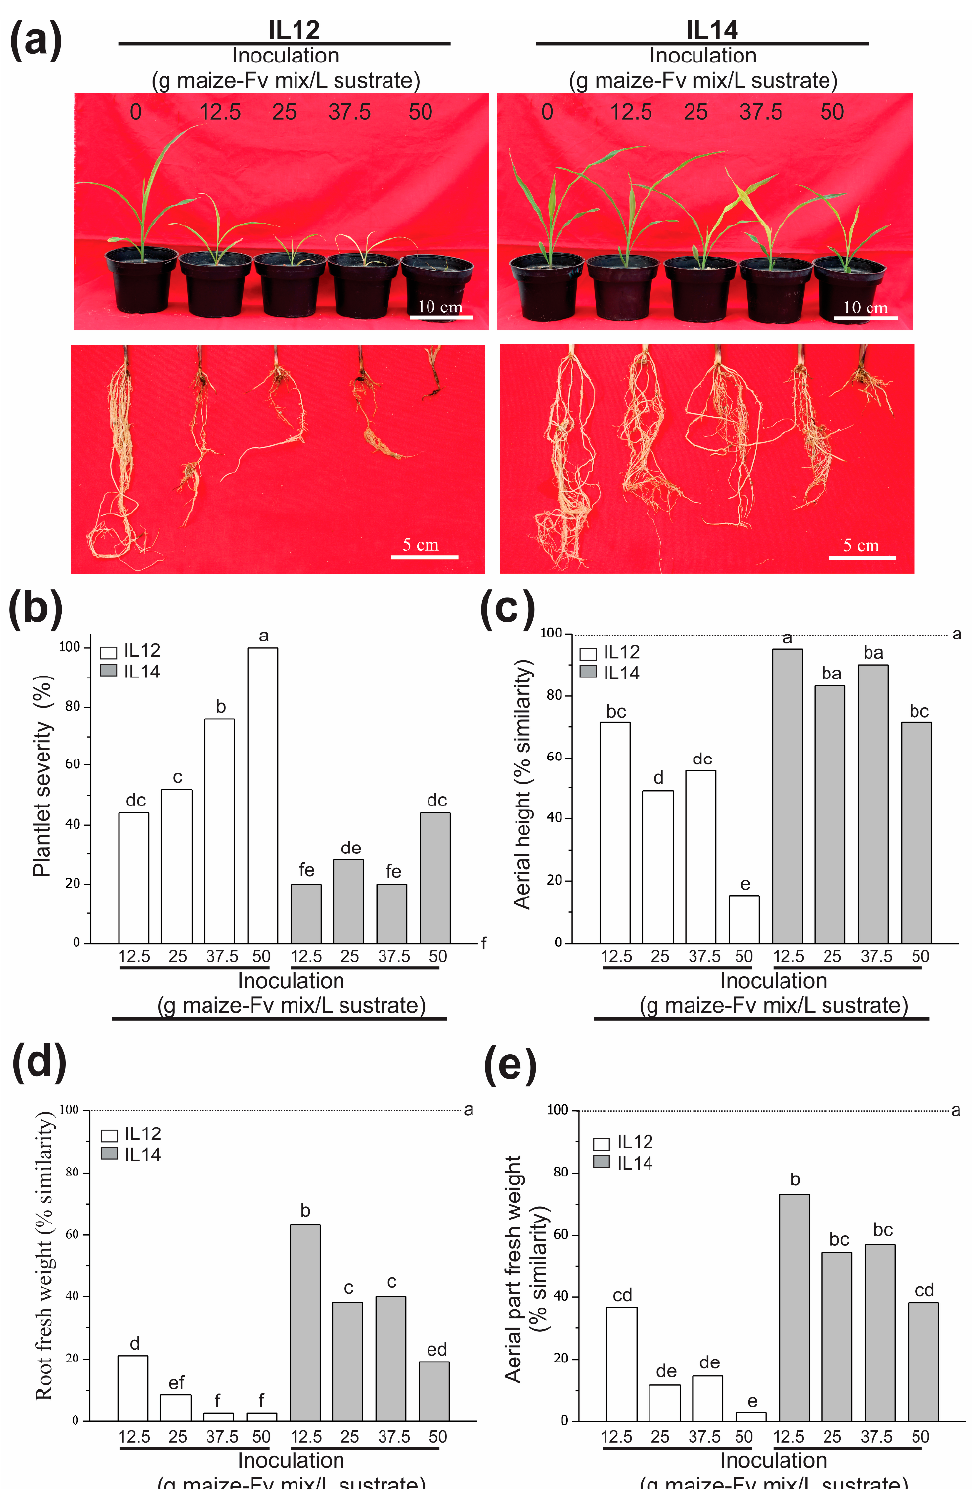
Figure 3. Fusarium effect on maize plants at the fourth leaf collar (V4 stage). ( a ) The aerial part and root development phenotypes are shown under different inoculum concentrations. The evaluation was made 30 days after transplanting. For quantitative evaluations of plantlet severity ( b ), aerial height ( c ), root fresh weight ( d ), and aerial fresh weight ( e ), the similarities were determined according to their controls. The different letters above the bars refer to significant differences using the Duncan mean test ( α = 0.01; n = 5). The dashed line at 100% represents the control value. The experiments were performed three times with a completely randomized design.